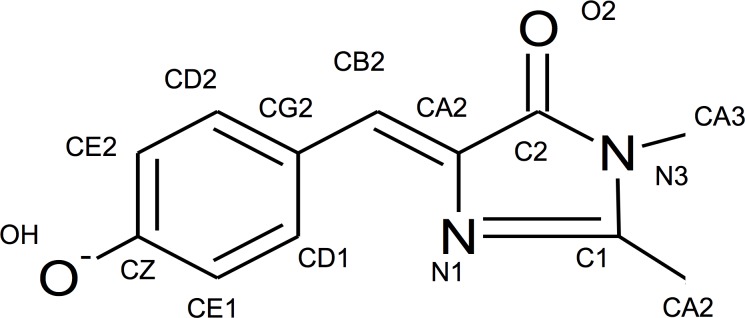
Atom numbering for the GCaMP chromophore.